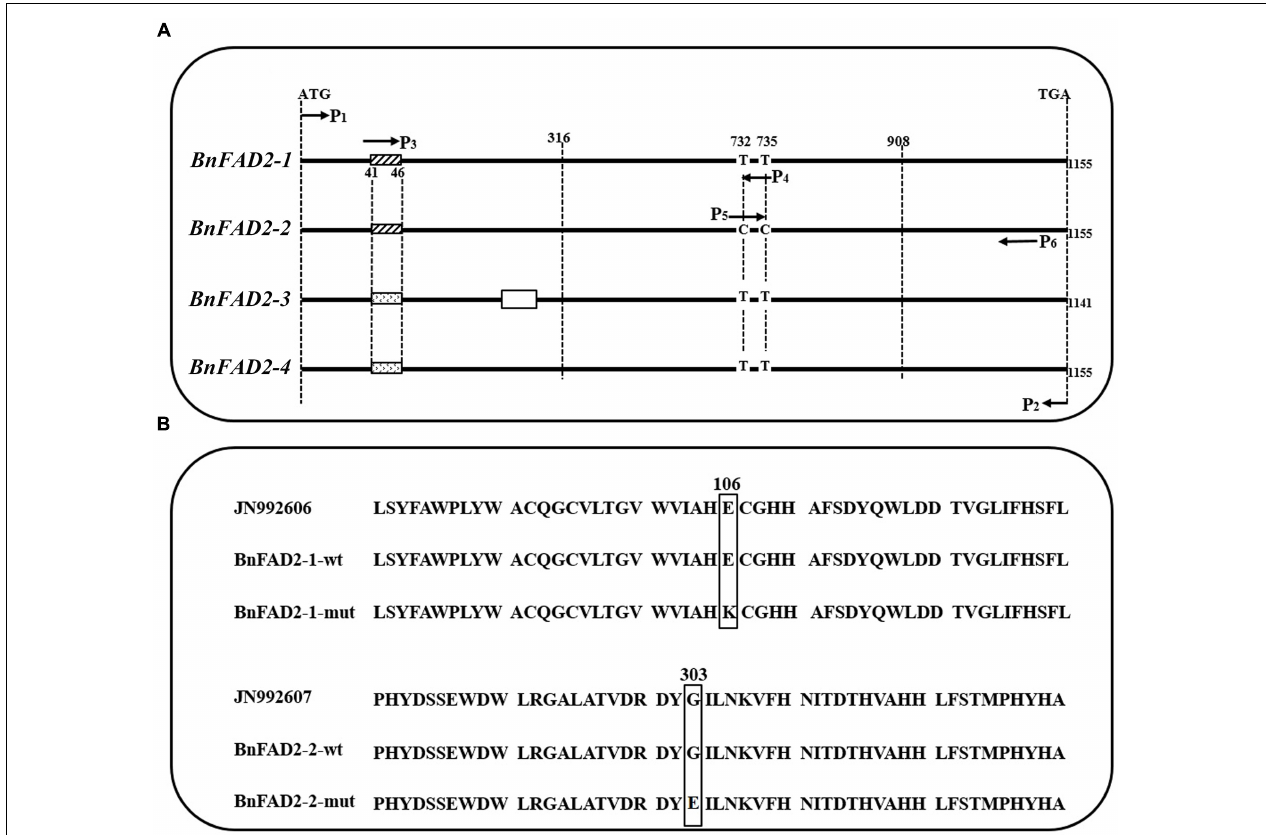
FIGURE 1 | Comparison of the four BnFAD2 groups and partial alignments of BnFAD2-1 and BnFAD2-2. (A) Sequence comparison highlighting the differences between BnFAD2-1 , BnFAD2-2 , BnFAD2-3 , and BnFAD2-4 . The white box in BnFAD2-3 indicates the missing 15-bp nucleotide sequence; the differently shaded boxes at 41–46 denote nucleotide difference. The BnFAD2 homolog genes have characteristic nucleotides at sites 732 and 735. ATG is the start codon; TGA, the stop codon. (B) Amino acid sequence alignment of the BnFAD2-1 and BnFAD2-2 peptides. The mutant amino acids are bracketed in square frames. The numbers represent the number of residues from the initiation amino acid Met. JN992606 and JN992607 were used as representative sequences (downloaded from GenBank). wt, wild-type; mut,